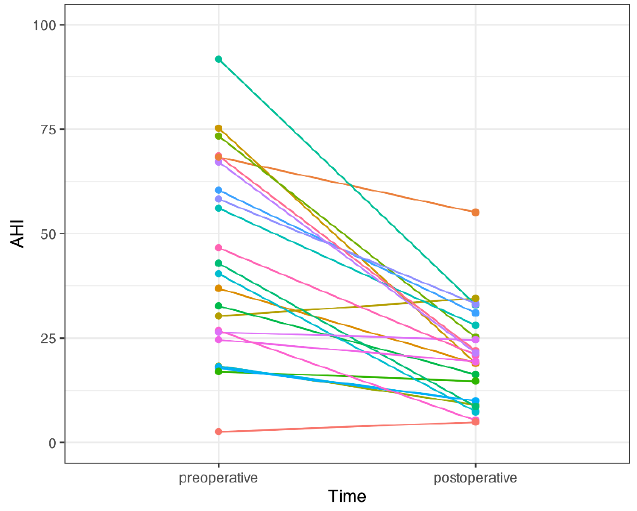
Figure 8. Preoperative and postoperative apnea/hypopnea index (AHI) in individual patients. Different colorful lines in individual patients to obtain a better visual